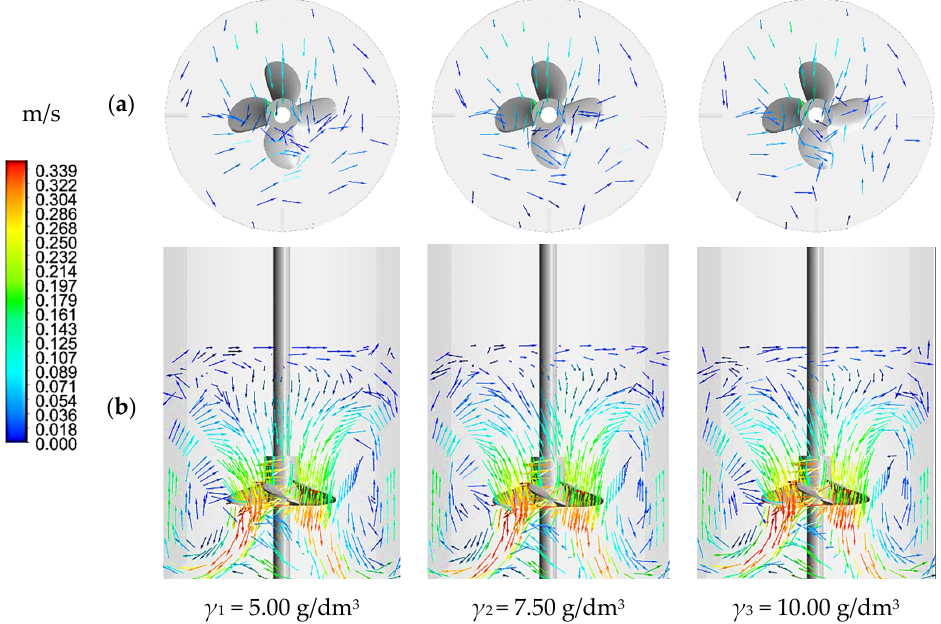
Figure 5. Vector plots and velocities in stationary frame contours in the reactor (top view at 0.12 suspension height ( a ) and side view ( b )) for three different mass concentrations of zeolite suspension.